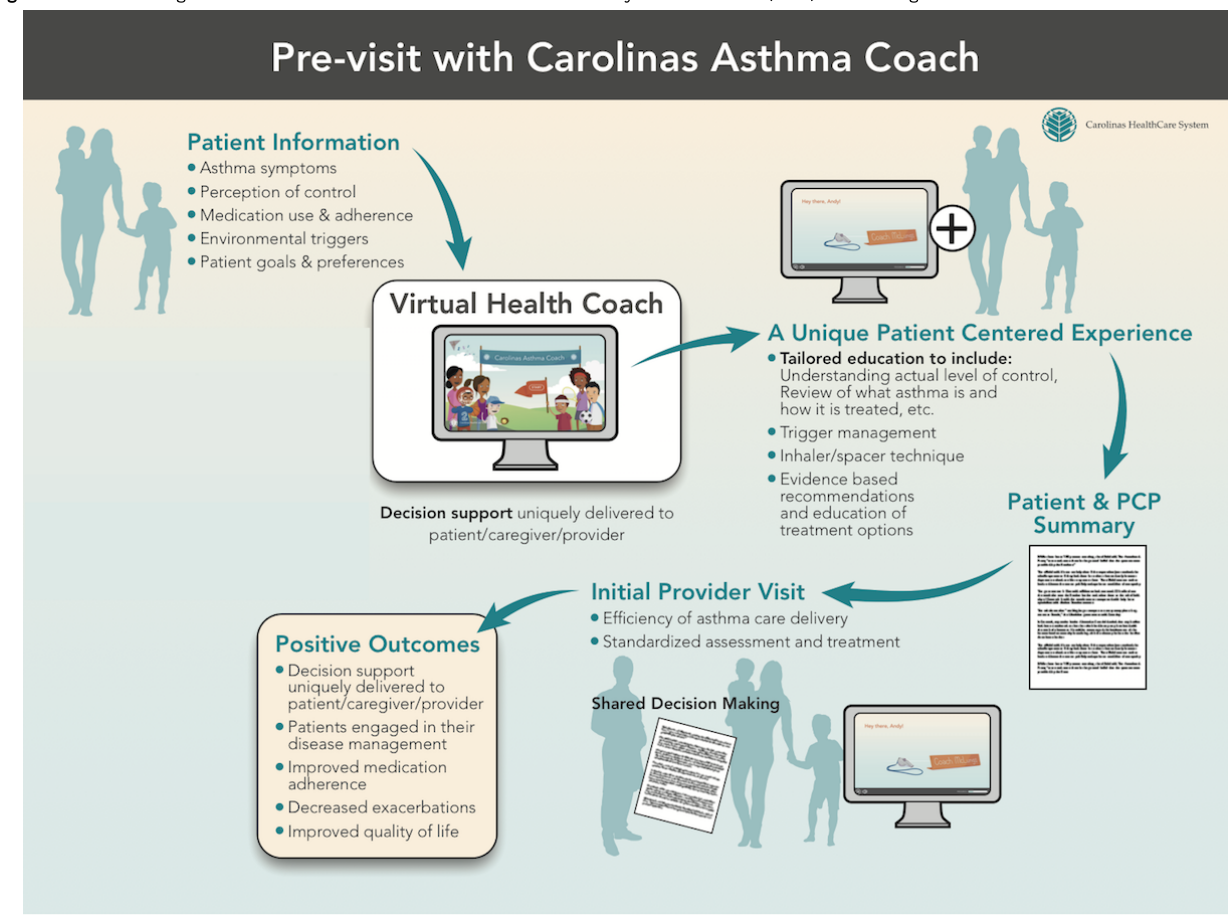
Figure 2. Process diagram for use of Carolinas Asthma Coach in a Primary Care Provider (PCP) visit